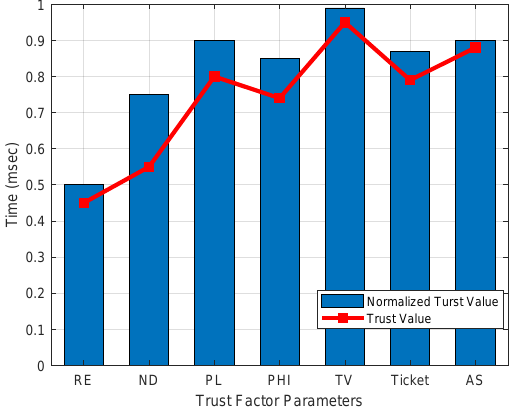
Figure 7. Relative normalized weights of the TV parameters for the handoff routing